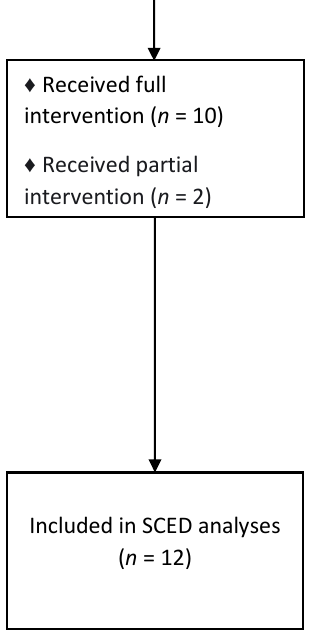
Figure A2. Study 2 participant flowchart.